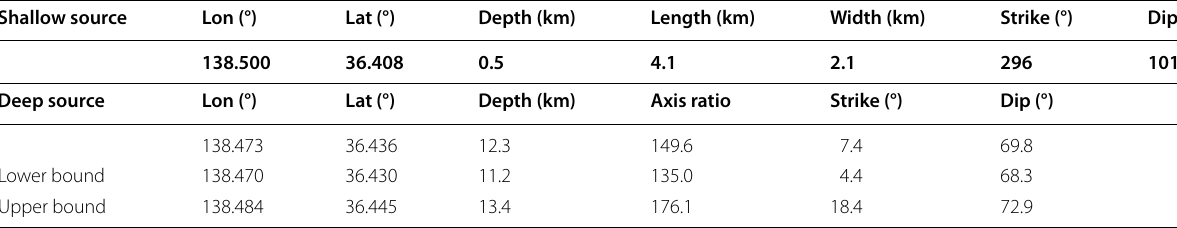
Lower and upper bounds represent 95% credible intervals. Figures in bold represent values fixed in the MCMC analysis